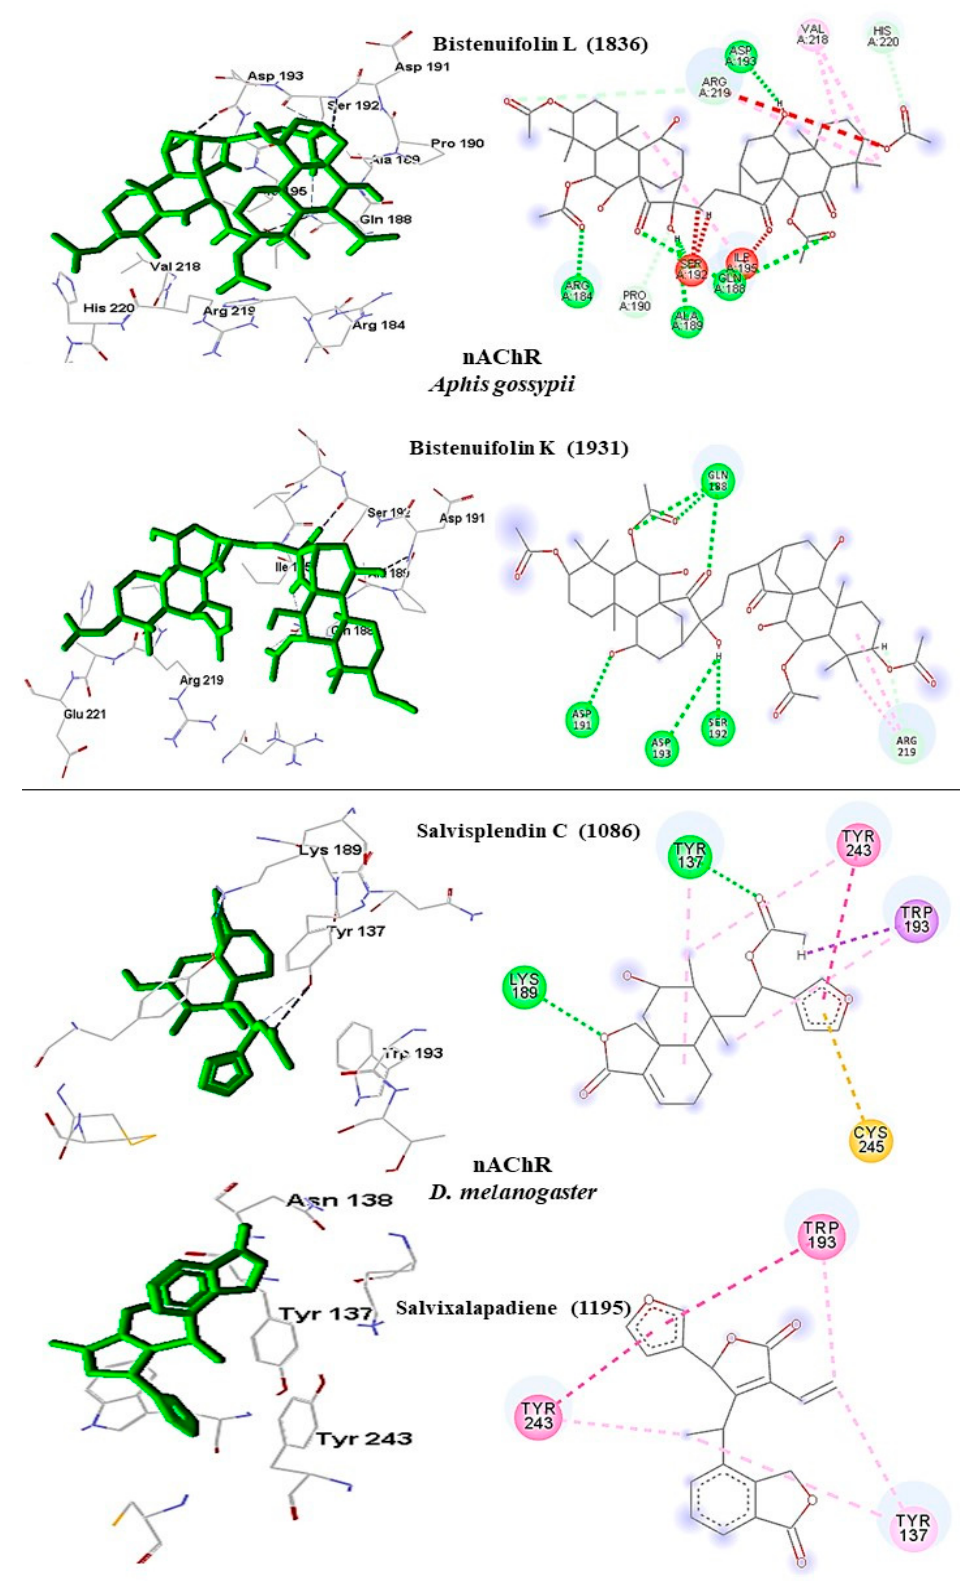
Figure 8. Interactions (3D and 2D) between 1836 and 1931 and A. gossypii -nAChR; and between 1086 and 1195 and D. melanogaster -nAChR. Hydrogen bonds are highlighted in green, hydrophobic interactions are highlighted in pink, and steric interactions are highlighted in red.